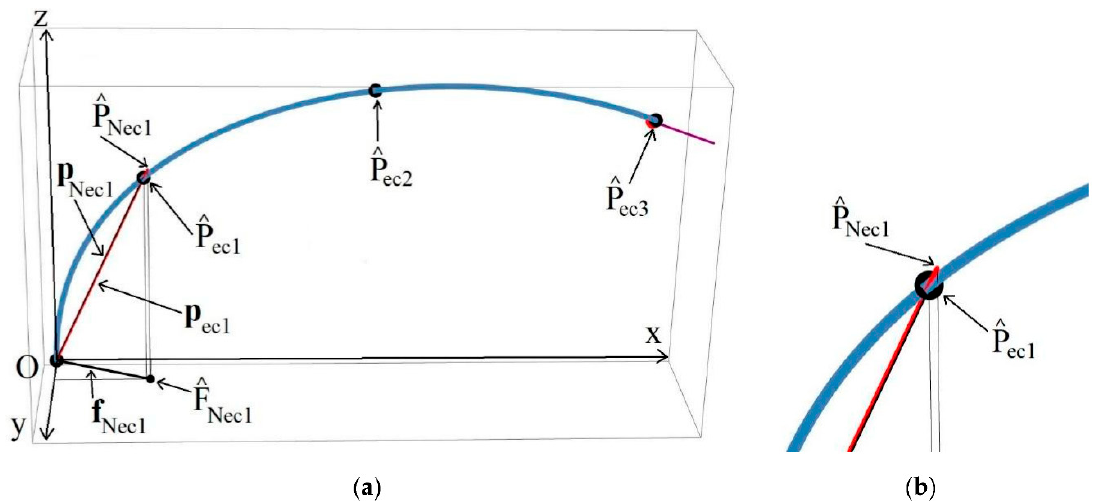
Figure 7. The first segment vector (cid:1816) (cid:2915)(cid:2913)(cid:2869) normalization and scaling to the new vector (cid:1816) (cid:2898)(cid:2915)(cid:2913)(cid:2869) : ( a ) vectors (cid:1816) (cid:2915)(cid:2913)(cid:2869) and (cid:1816) (cid:2898)(cid:2915)(cid:2913)(cid:2869) with approximate bent robot spine curve view; ( b ) vectors (cid:1816) (cid:2915)(cid:2913)(cid:2869) and (cid:1816) (cid:2898)(cid:2915)(cid:2913)(cid:2869) endpoints, zoomed in.